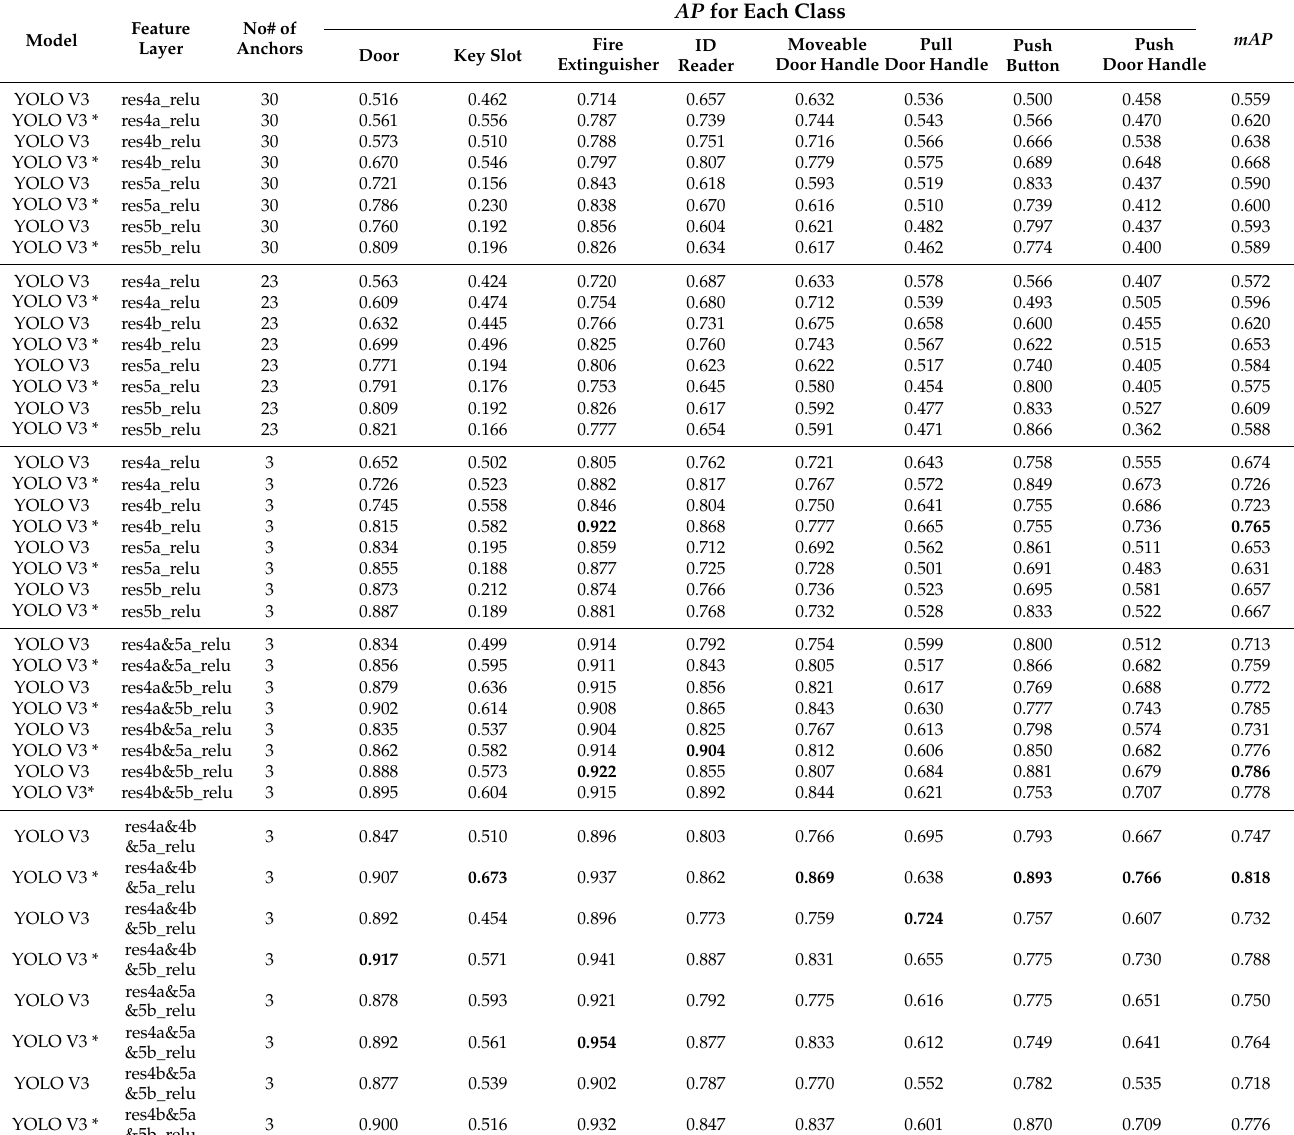
Table 5. Detectors detailed results on the test set (YOLO V3 with